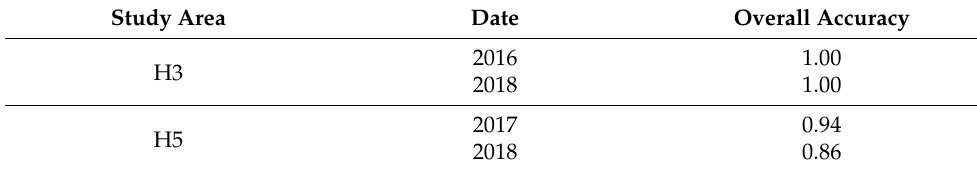
Table 7. Summary of the gains and losses per sediment class. Values presented are calculated in respect to the total study area (H3= 4.71 km 2 and H5 = 1.81 km 2 ).